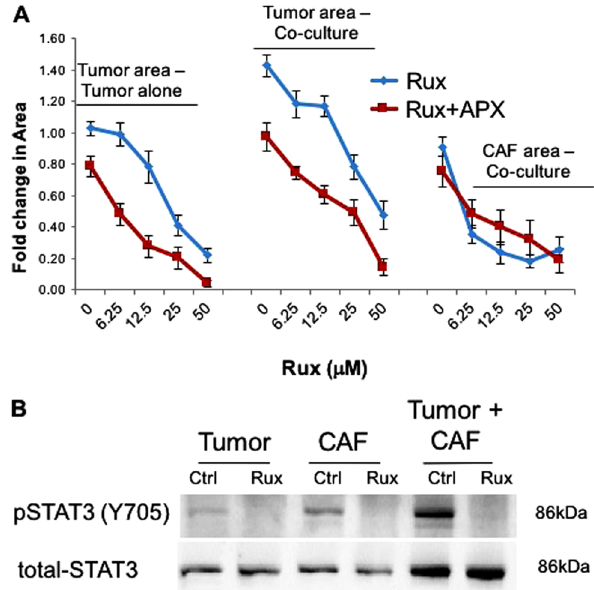
Fig. 3 Dual-targeting of Ref-1/APE1 and Jak/STAT signaling inhibits PDAC tumor growth in a 3D co-culture model. a Low passage patient-derived tumor cells, Pa03C were grown in 3D cultures in the presence and absence of CAFs. Spheroids were treated with Ruxolitinib alone ( blue curve ) and in combination with APX3330 (40 μ M, red curve ), and the area of tumor ( red ) and CAF19#1 ( green ) were quanti fi ed following 12 days in culture, n = 4; fold change refers to comparison of drug-treated vs. media only in the tumor alone spheroids. b Con fi rmation of inhibition of STAT3 activation was done via immunoblotting for pSTAT3 Y705 residue after 4 h of Ruxolitinib treatment (12.5 μ M) in the 3D assay 8 – 10 days post plating. Total STAT3 protein is provided as a loading control and reference for the levels of STAT3 in both cell types. Representative western blot is shown from an n of